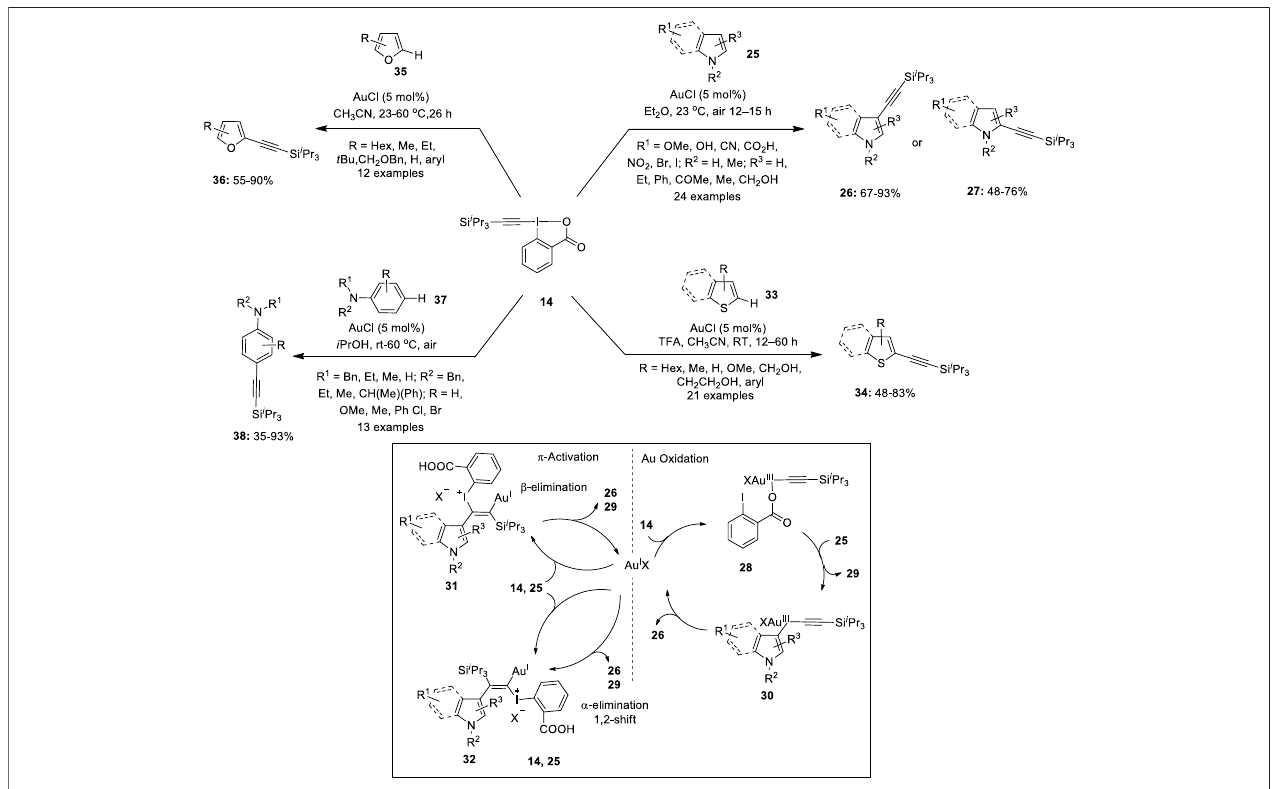
FIGURE 4 | Gold-catalyzed C – H alkynylation of arenes/hetero-arenes using a benziodoxolone-derived hypervalent iodine reagent 14 as an acetylene transfer reagent.